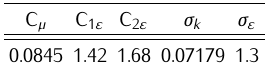
The multiple reference frames (MRF) approach allows for the modeling of stirred tanks and tanks with other inter- nal components. A rotating frame ( ω 1 ) is used for the region containing the rotating components while a sta- tionary frame ( ω 2 ) is used for regions that are stationary (Figure 2). In the rotating frame containing an impeller, the impeller is at rest. Conversely, in the stationary frame containing the tank walls and baffles, the walls and baf- fles are at rest. The grid used for MRF solution must have a perfect surface of revolution surrounding each rotating frame. The momentum equations inside the rotating frame are solved in the frame of the enclosed impeller while those outside the rotating frame are solved in the station- ary frame. A steady transfer of information is made at the MRF interface as the solution progresses. While the so- lution of the flow field in the rotating frame in the region surrounding the impeller imparts the impeller rotation to the region outside this frame, the impeller is taken to be stationary during this type of